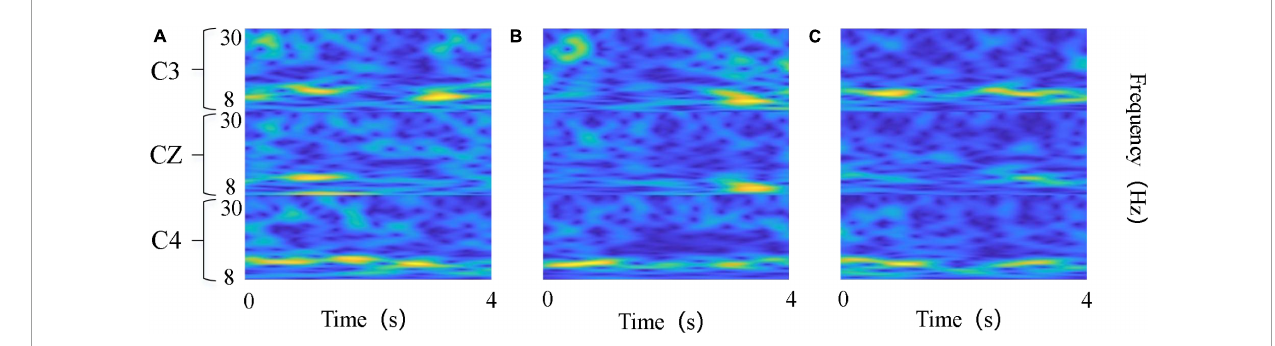
FIGURE2 Time-frequency maps of the three kinds of tasks. (A) Left wrist rotation; (B) cup grasping; (C) forward arm extension. The abscissa denotes time points, and the ordinate denotes frequency